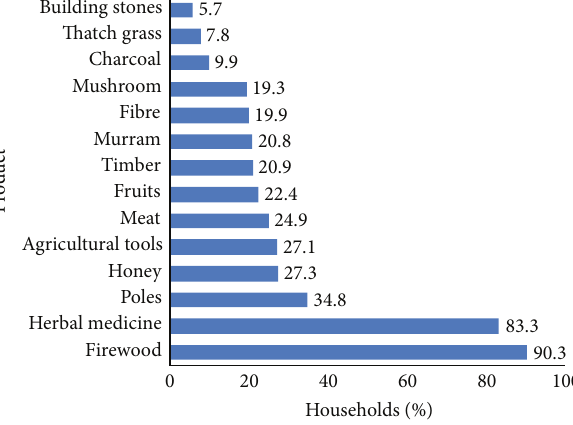
Figure 2: Proportion of households (%) collecting various forest products from East Mau